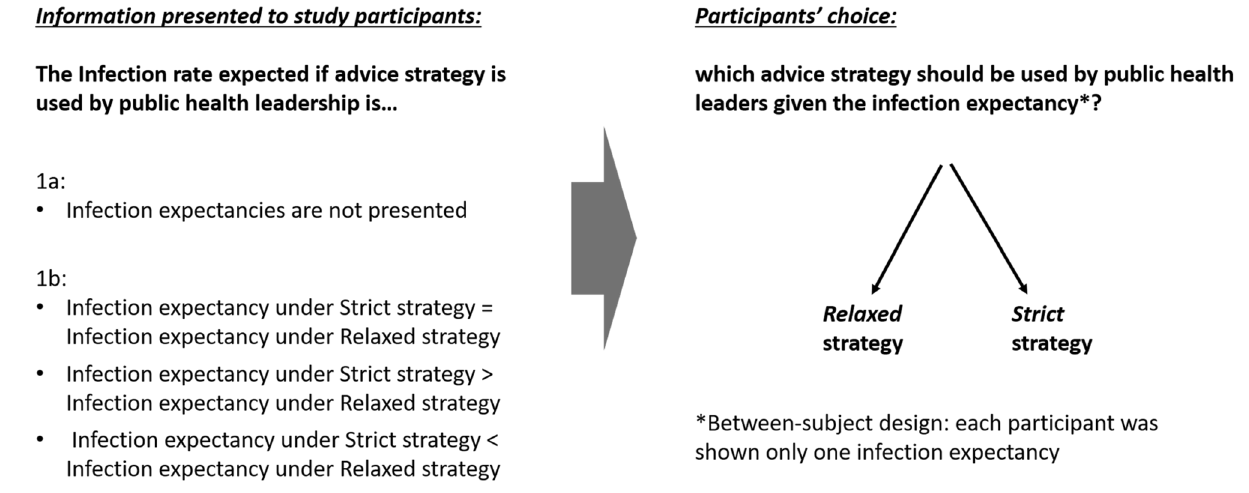
Figure 3. Experiment design, Study